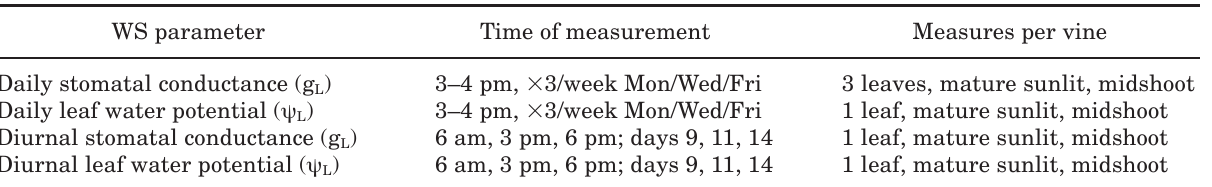
Table 1. Measurements of water stress (WS) in experimental Cabernet Sauvignon and Chardonnay grapevines. WS parameter Time of